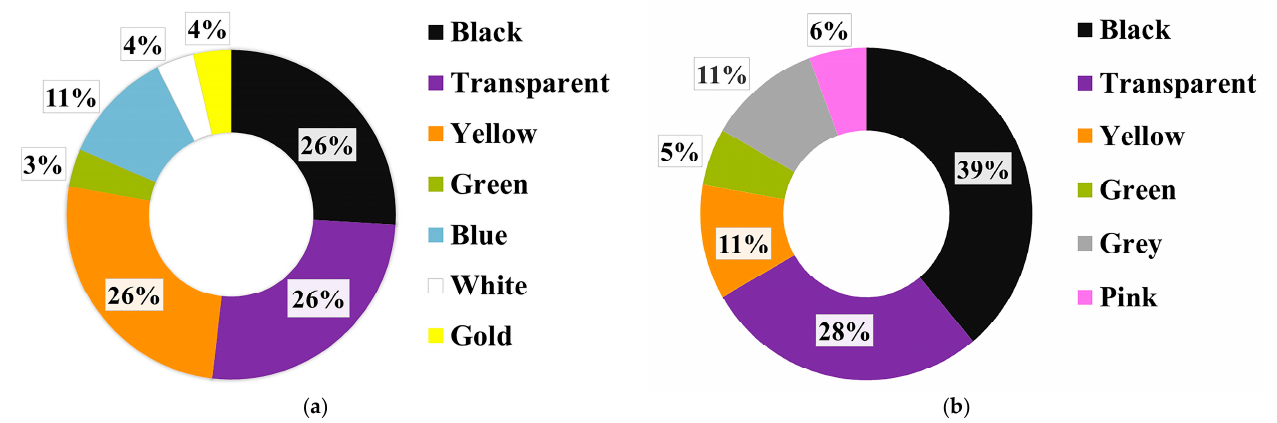
Figure 5. The percentages of different colours of MPs in order Perciformes: ( a ) in the AS; ( b ) in the RS, Antarctica.